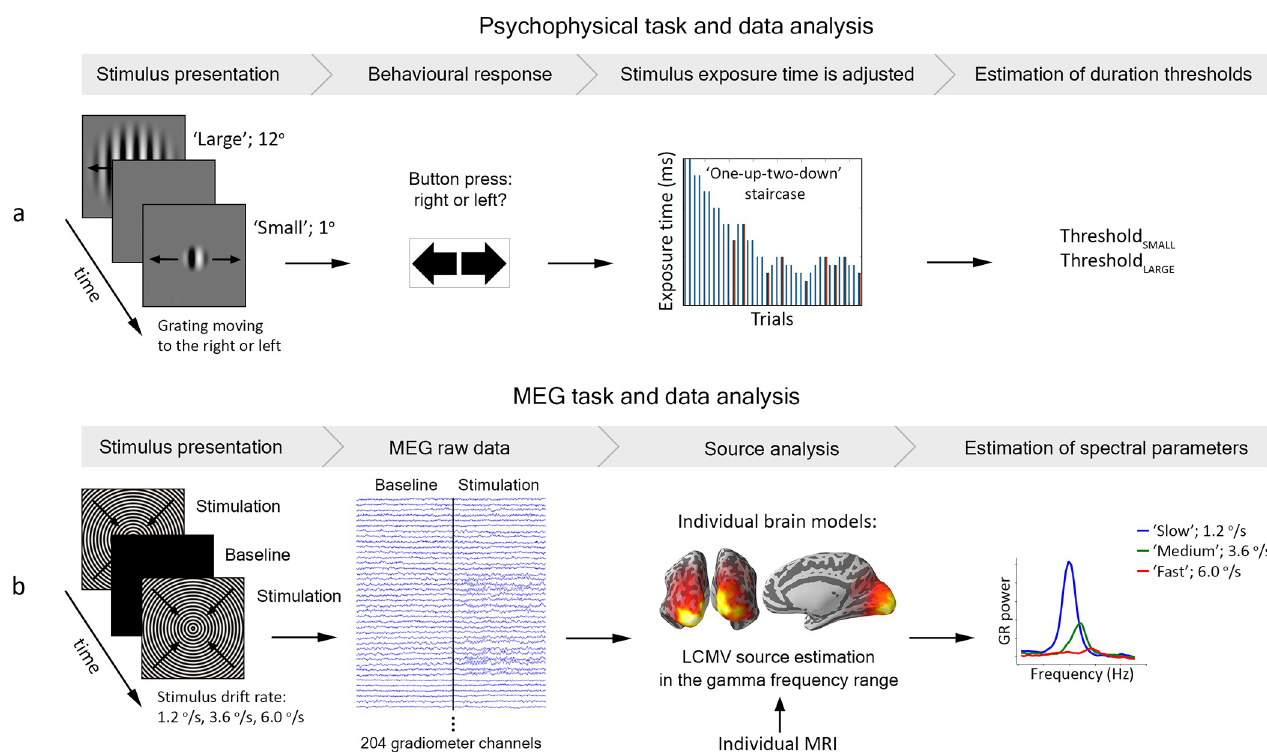
Fig 1. Overview of the data collection and analysis pipelines. (a) Psychophysical experiment. Large or small gratings moving left or right were presented for a short period of time. The subject had to indicate the direction of motion by pressing the corresponding button. In case of a wrong response the exposure time increased, while in case of two correct responses in a row it decreased (‘one-up—two-down staircase’). The minimum time required for the subject to detect direction of motion (i.e. duration threshold) of small and large gratings was defined as the average exposure time at all but the first two ‘reversals’ of the corresponding staircase. (b) MEG experiment. The subject was presented with circular gratings drifting toward the center at different speeds. Brain activity corresponding to baseline and visual stimulation intervals was localized using LCMV beamforming. Stimulation-related changes in gamma power (gamma response) were calculated as (stimulation-baseline)/baseline. The peak frequency and power of gamma response (GR) were analyzed at ‘maximal sources’ in the visual cortex. For a detailed description of the experimental procedures and analysis, see the Methods